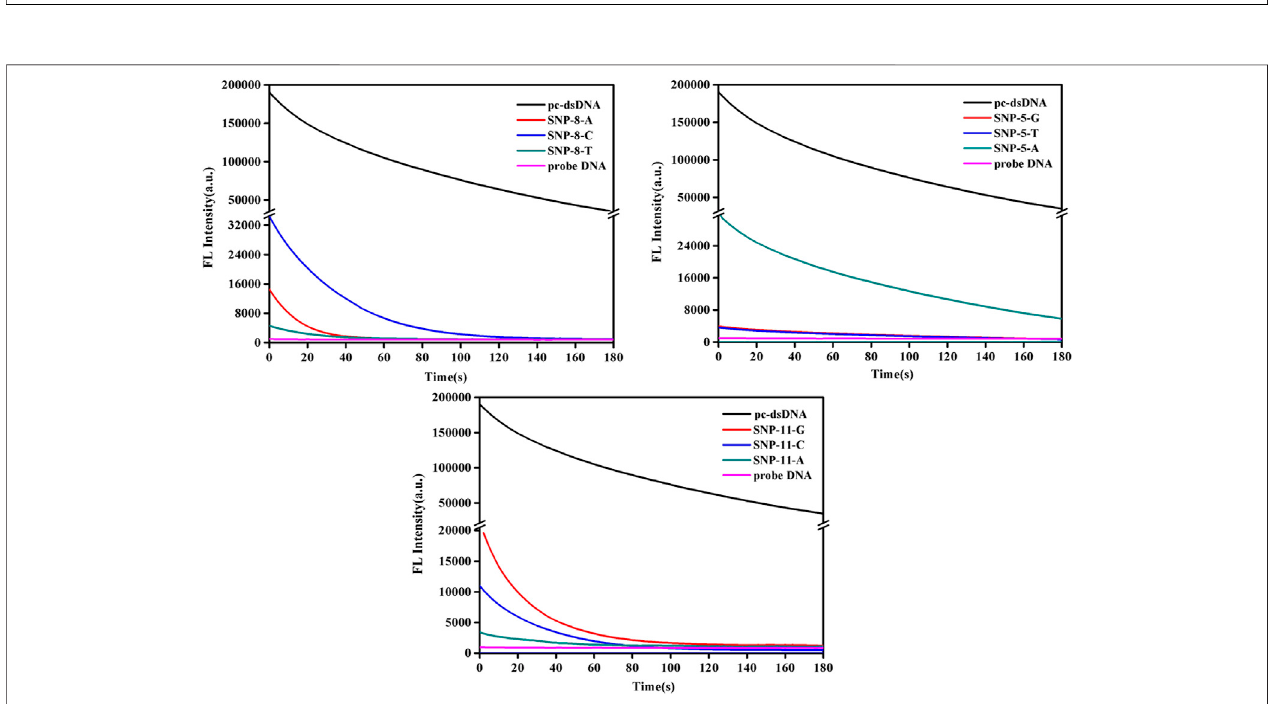
FIGURE2| EmissionspectraofGOonthedetectionofSNPs(SNP-8,SNP-5,andSNP-11).The fi nalconcentration:[SNPs] (cid:2) 10 nM,[probeDNA] (cid:2) 10 nM,[GO] (cid:2) 2.5 μ g/ml, 10 mM phosphate buffer (20 mM NaCl, pH 7.4).